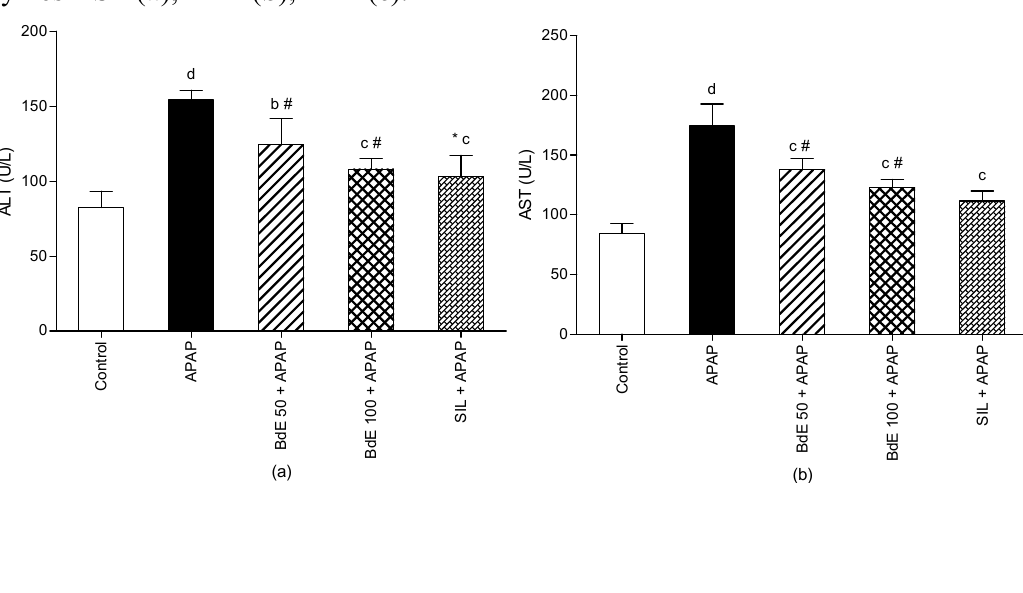
Figure 3. Effect of BdE on rats intoxicated with acetaminophen (APAP). Levels of